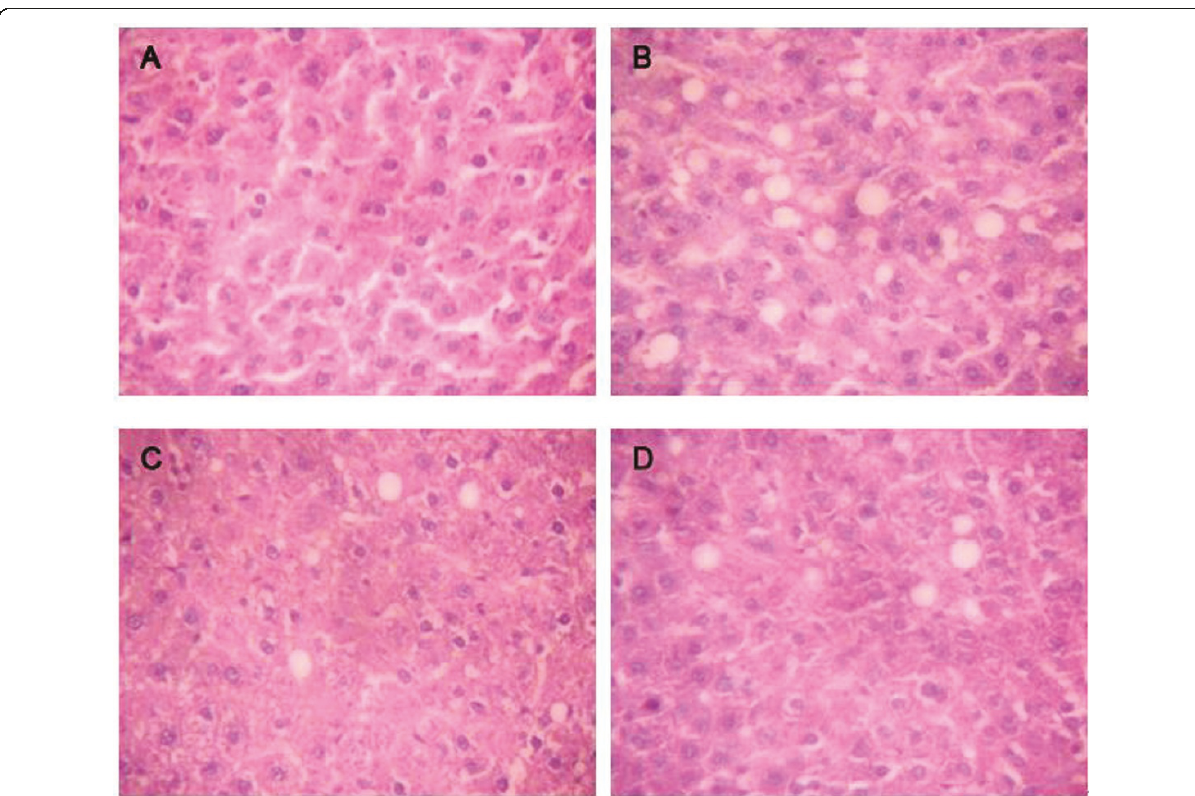
Figure 2 Histology of liver steatosis in the four groups . A: normal diet; B: high-cholesterol diet; C: high-cholesterol diet + L. plantarum 9-41- A; D: high-cholesterol diet+ L. fermentum M1-16. All the photomicrographs show HE staining (original magnification × 400).